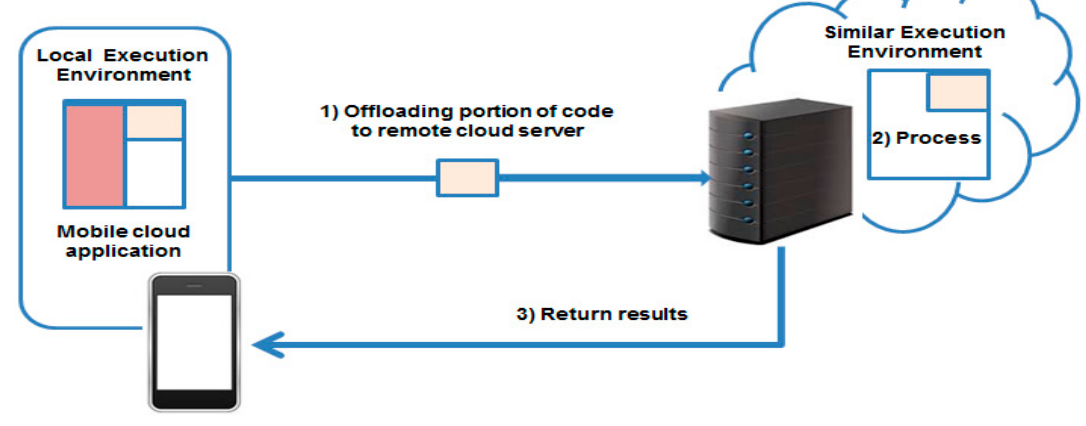
Figure 1. Offloading process.